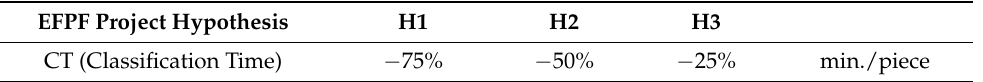
Table 2. Reference of classification time reduction because of factory connectivity